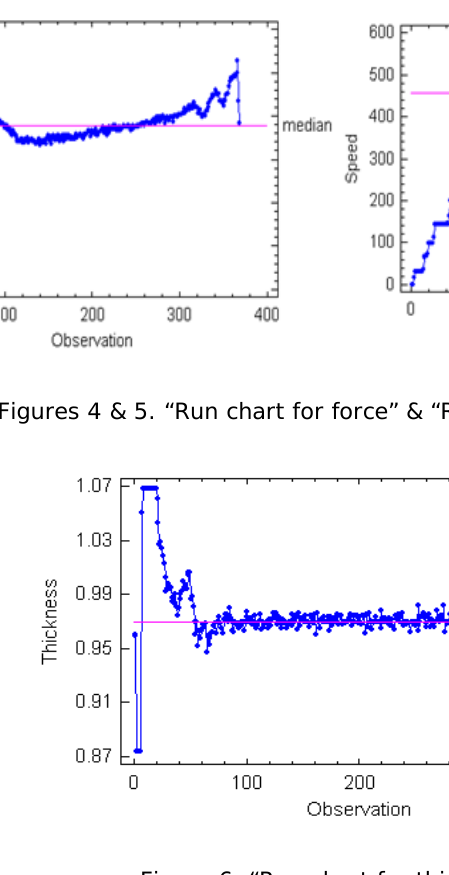
Figure 6. “Run chart for thickness”.